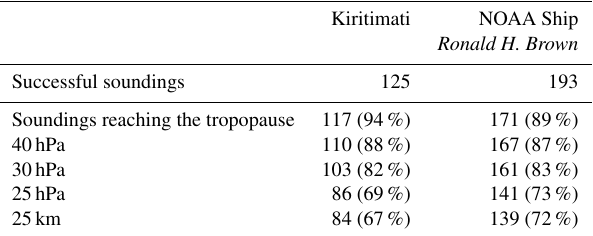
Table 4. Gross characteristics of the ENRR sounding data sets from Kiritimati and NOAA Ship Ronald H. Brown .